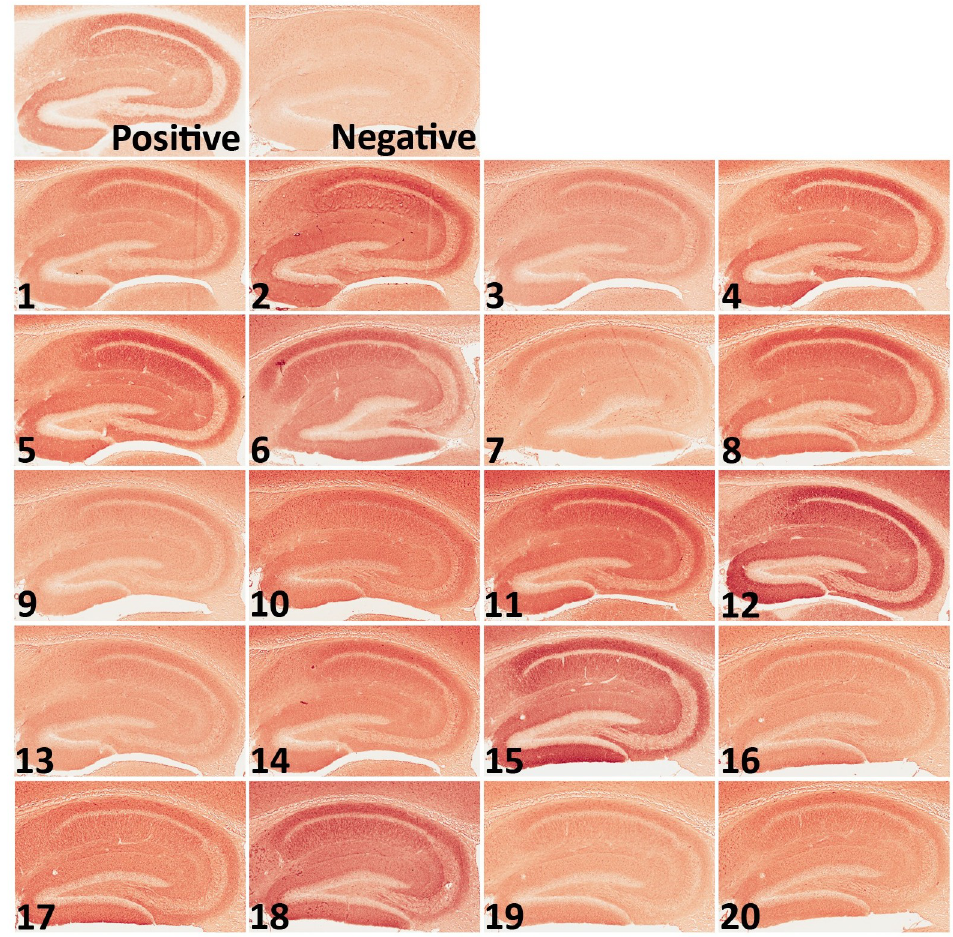
Fig 5. Generation of the anti-NMDAR1 autoantibodies in a large cohort. A large cohort of 40 mice (20 males and 20 females) was immunized with either the P2 plus the CFA or the CFA only. After improving the antigen emulsification using the LOS syringes, all mice (10 males and 10 females) immunized with the P2 plus the CFA generated anti- NMDAR1 autoantibodies. No difference was observed between the males and females. All of the control mice (10 males and 10 females) immunized with the CFA only are negative for the autoantibodies against the NMDAR1 P2